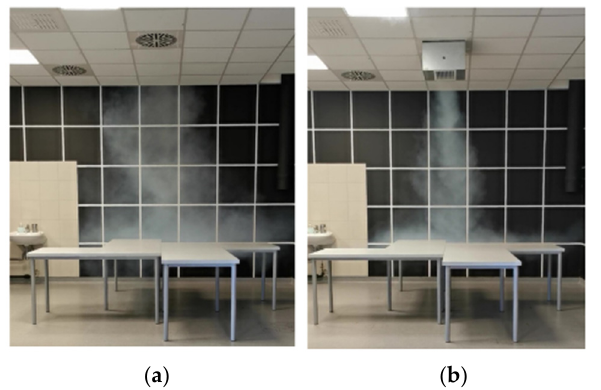
Figure 11. Air Flow pattern without ( a ) and with the air-jet control box ( b ) including plexiglass examined with the “Island of four” setup.